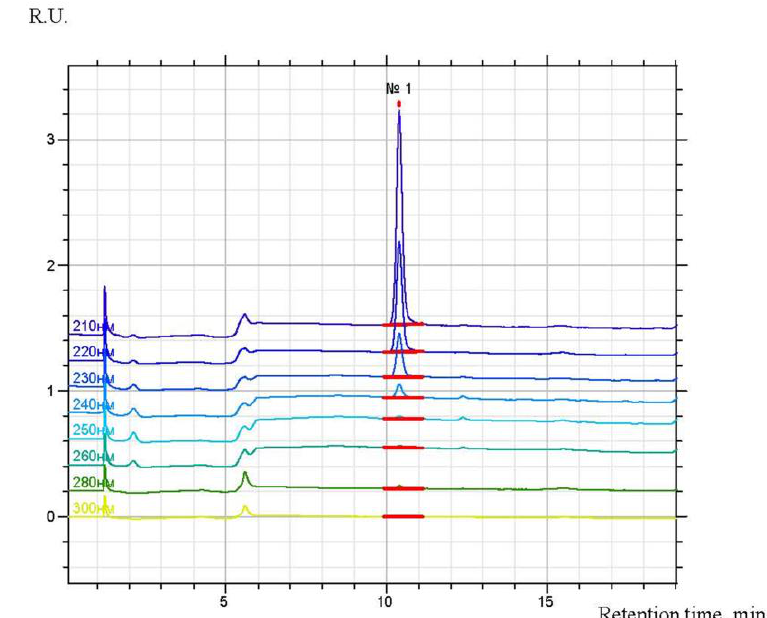
Fig. 1. Chromatogram of clonidine hydrochloride (concentration – 100.0